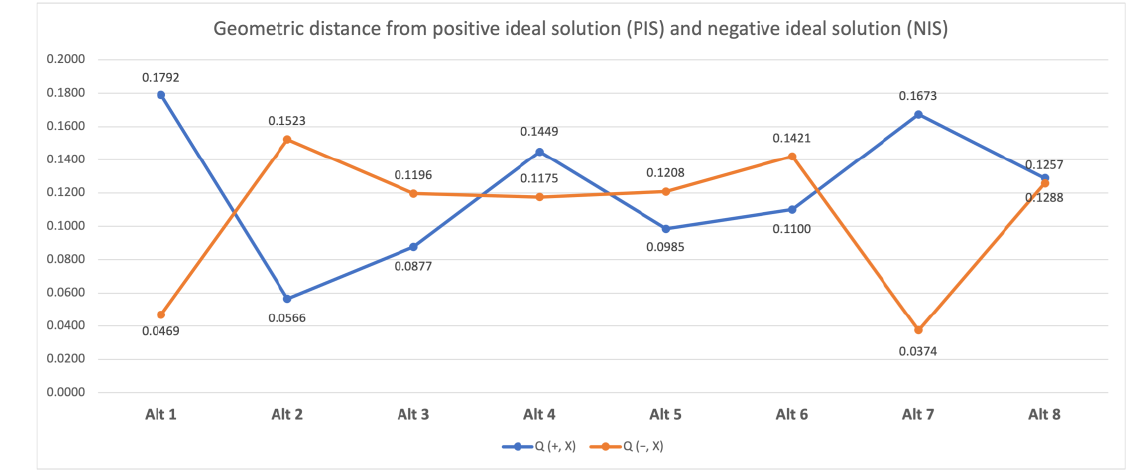
Figure 7. Geometric distance of all alternatives from PIS and NIS. The optimal solution ranking based on the index value C x in the TOPSIS model is shown in Figure 8.